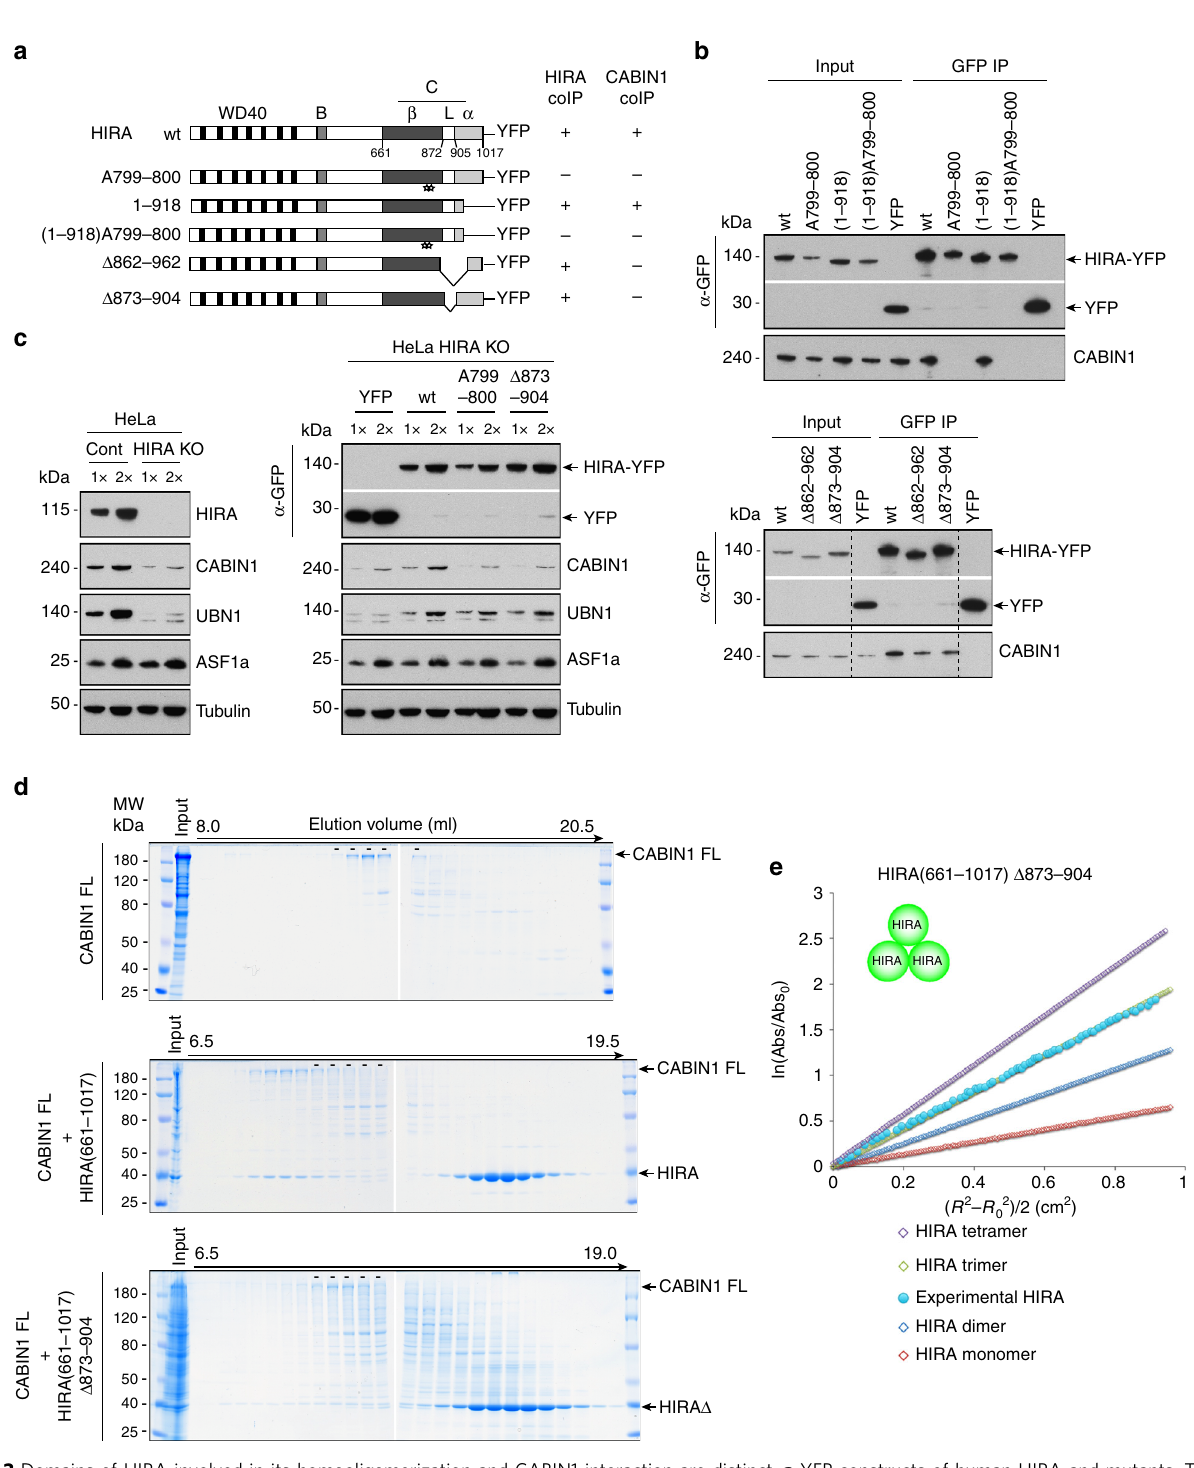
Fig. 3 Domains of HIRA involved in its homooligomerization and CABIN1 interaction are distinct. a YFP constructs of human HIRA and mutants. Three different structures matching the previously described C domain are indicated: β -strand (aa 661 – 872), loop (aa 873 – 904) and α -helical (aa 905 – 1017) domains. Star indicates single amino acid substitution with alanine. The co-immunoprecipitation ef fi ciency of endogenous CABIN1 (CABIN1 coIP) is indicated for each construct, “ + ” indicates that the ef fi ciency of coIP is similar to the one obtained with the wt HIRA construct and “ − ” indicates that the ef fi ciency of the coIP is decreased. b Western blot analysis of anti-GFP-immunoprecipitates from U2OS nuclear extracts expressing YFP-tagged proteins. Input corresponds to 10% of nuclear extract used for each experiment. c (Left) Western blot analysis of nuclear extracts from HIRA KO and control HeLa cells. (Right) Western blot analysis of nuclear extracts from HeLa HIRA KO cells expressing YFP-tagged proteins. d Superose 6 fractionation of recombinant proteins CABIN1 FL, CABIN1 FL + HIRA(661 – 1017) and CABIN1 FL + HIRA(661 – 1017) Δ 873 – 904. The dashes indicate the fractions in which free CABIN1 FL elutes. Input corresponds to protein at the concentration that it was loaded onto the Superose 6 column. e Equilibrium sedimentation